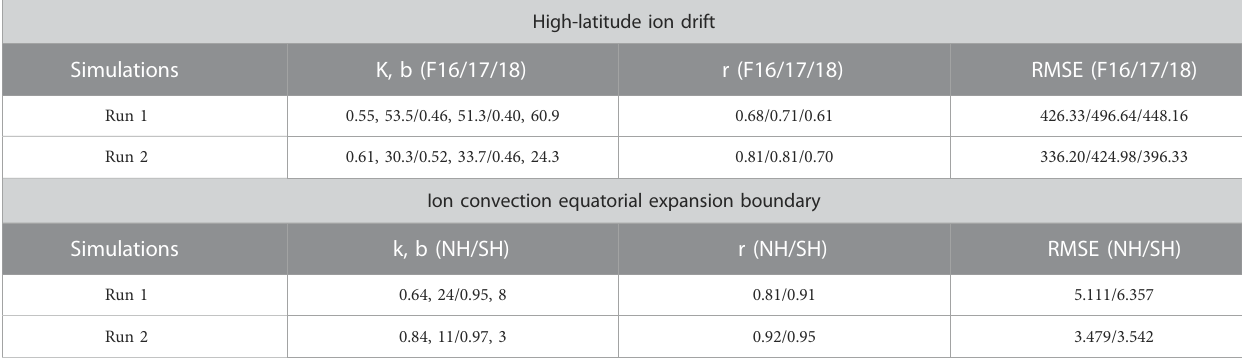
Figure 6 shows the temporal variations of the cross-polar-cap potential (CPCP, top panel) and hemispheric power (HP, bottom panel) during October 8 – 9, 2012, from run 1 (left) and run 2 (right). The vertical dashed line marks the time when IMF B y is reversed (00: